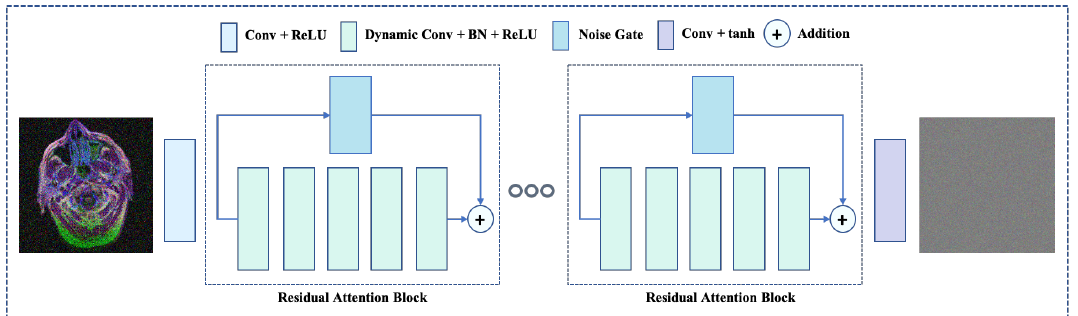
Figure 2. The overview of proposed network architecture. The proposed network incorporates novel dynamic residual attention blocks, which utilizes dynamic convolution and a noise gate. Also, the network leverage the residual learning along with the learning feature